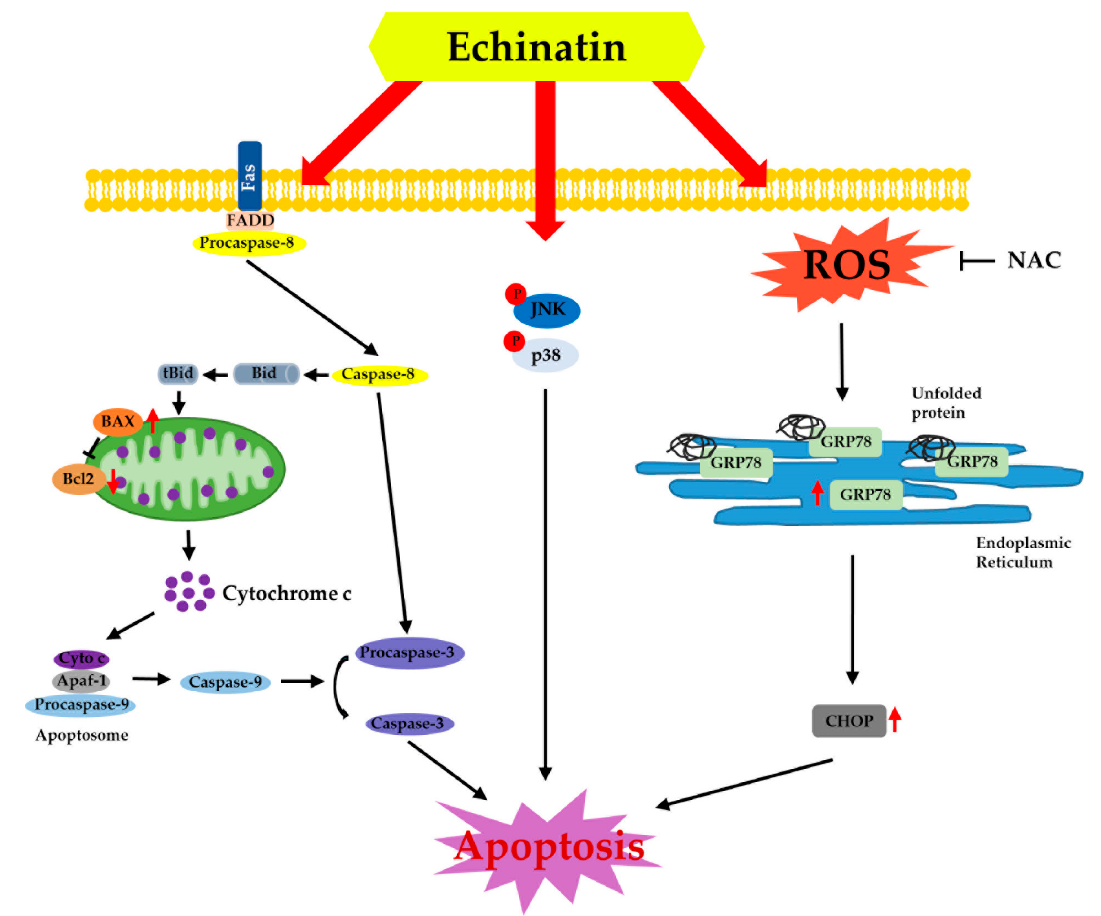
Figure 7. Schematic showing Ech-induced cell death. Ech induces ROS production and activates p38 and JNK MAPK kinases, or stimulates ER stress. p38 and JNK MAPK kinases signaling cascades increase death receptor expression and caspase-8 / Bid activation, BAX expression, Bcl2 reduction, and cytochrome c release (cytosol), which then induces Apaf-1 / caspase9 or caspase-3 activation, thus resulting in cell apoptosis. On the other hand, ER stress with increasing GRP78 and CHOP expression will induce cancer cell apoptosis.